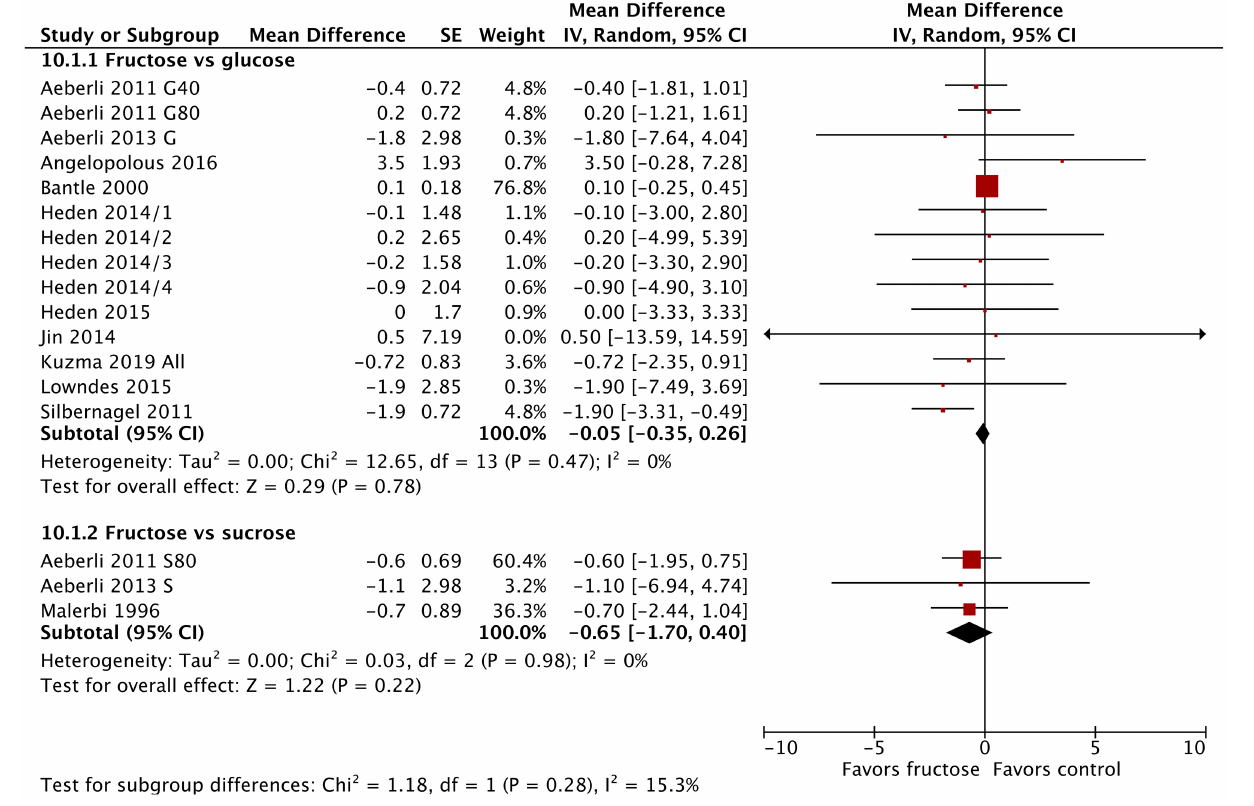
FIGURE 5 | Subgroup meta-analysis of body weight following isoenergetic substitution of glucose or sucrose by fructose in food or beverages by substituted sugar. Values are mean differences (95% CIs) (expressed as kg) between fasting blood glucose after fructose consumption and fasting blood glucose following glucose or sucrose consumption. IV, inverse variance; SE, standard error; G40, fructose/glucose 40 g/day; G80, fructose/glucose 80 g/day; G, glucose; S, sucrose; I, impaired glucose tolerance, N, normal glucose tolerance/body weight; O,